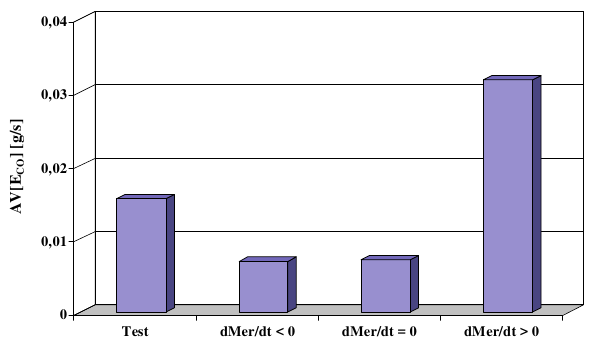
Fig. 21. Mean value of the carbon monoxide exhaust emission in the Malta test and in the states corresponding to the negative, zero and positive values of the engine speed derivative with respect to time